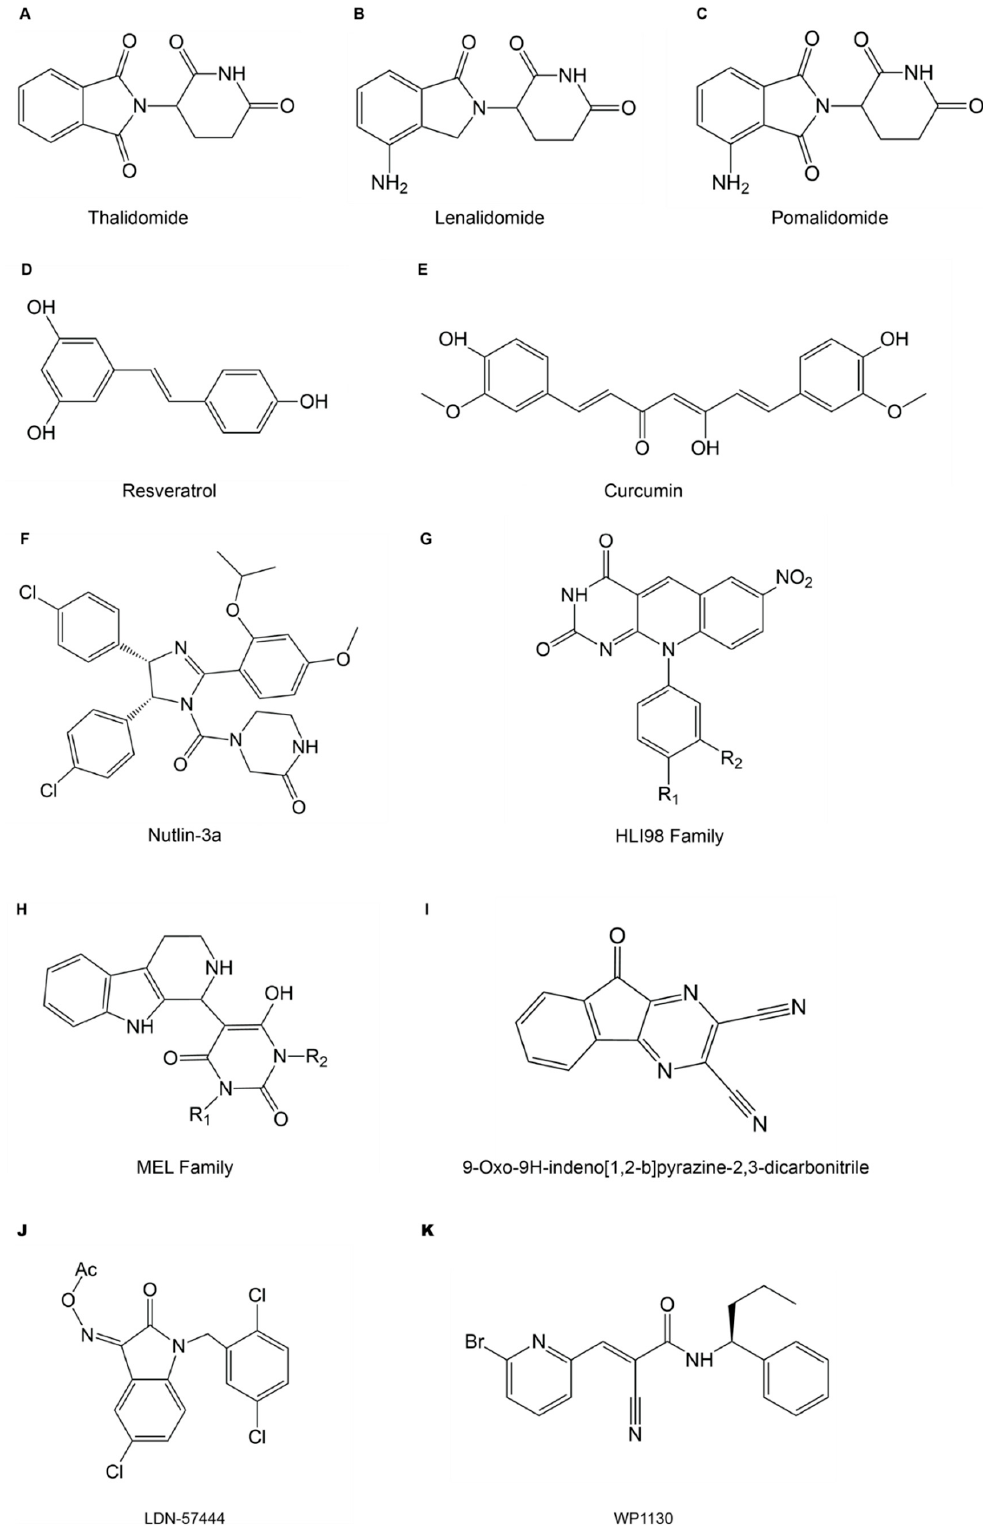
Figure 6. Chemical structures of small molecule inhibitors. ( A – C ) Immunomodulatory drugs (IMiDs): thalidomide ( A ) and its derivatives lenalidomide ( B ) and pomalidomide ( C ). ( D – E ) PD-L1 modulatory drugs: resveratrol ( D ) and curcumin ( E ). ( F – H ) MDM2 inhibitors: nutlin-3A ( F ), HLI98 family ( G ) and MEL family compounds ( H ). ( I ) USP8 inhibitor: 9-oxo-9 H -indeno [1,2-b]pyrazine-2,3-dicarbonitrile. ( J ) UCHL1 inhibitor: LDN-57444. ( K ) USP9X inhibitor: